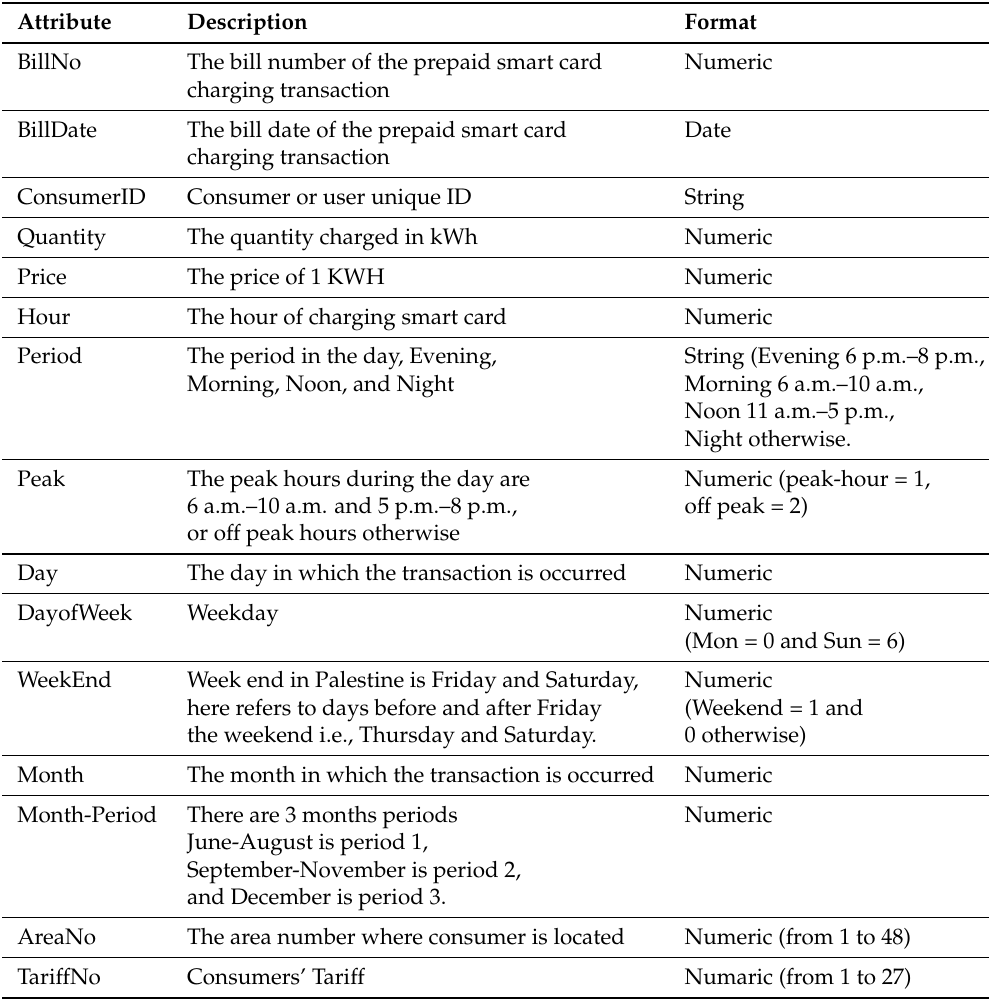
Table 1. Data set attributes and